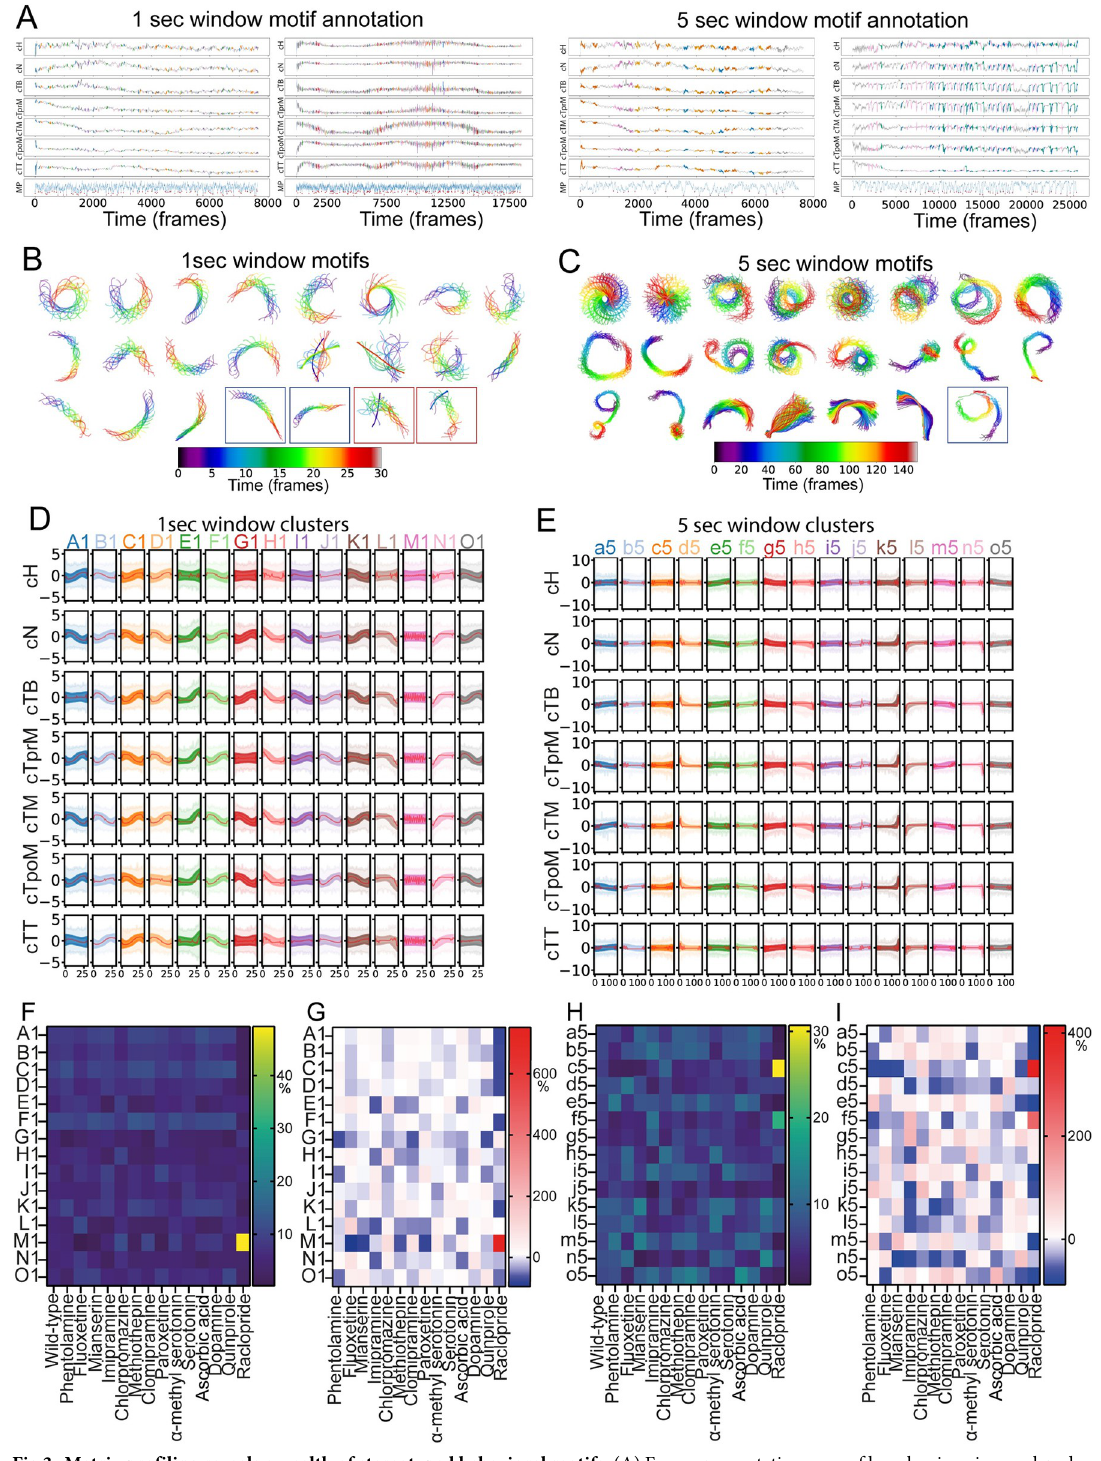
Fig 3. Matrix profiling reveals a wealth of stereotyped behavioral motifs. (A) Four representative cases of larval swimming analyzed using matrix profiling. Curvatures of 7 body segments were used as the input. The matrix profile for each animal is shown as an additional row at the bottom of each plot (labeled as MP). Each dip marked with a red dot indicates the onset of a motif that recurs in the dataset. Each motif is color coded according to the cluster it belongs to. (B) Representative examples of motifs that are enriched in the 1-second time window. Color-coded skeletons of the animals plotted in sequence to show time progression (0 ➔ 30 frames,